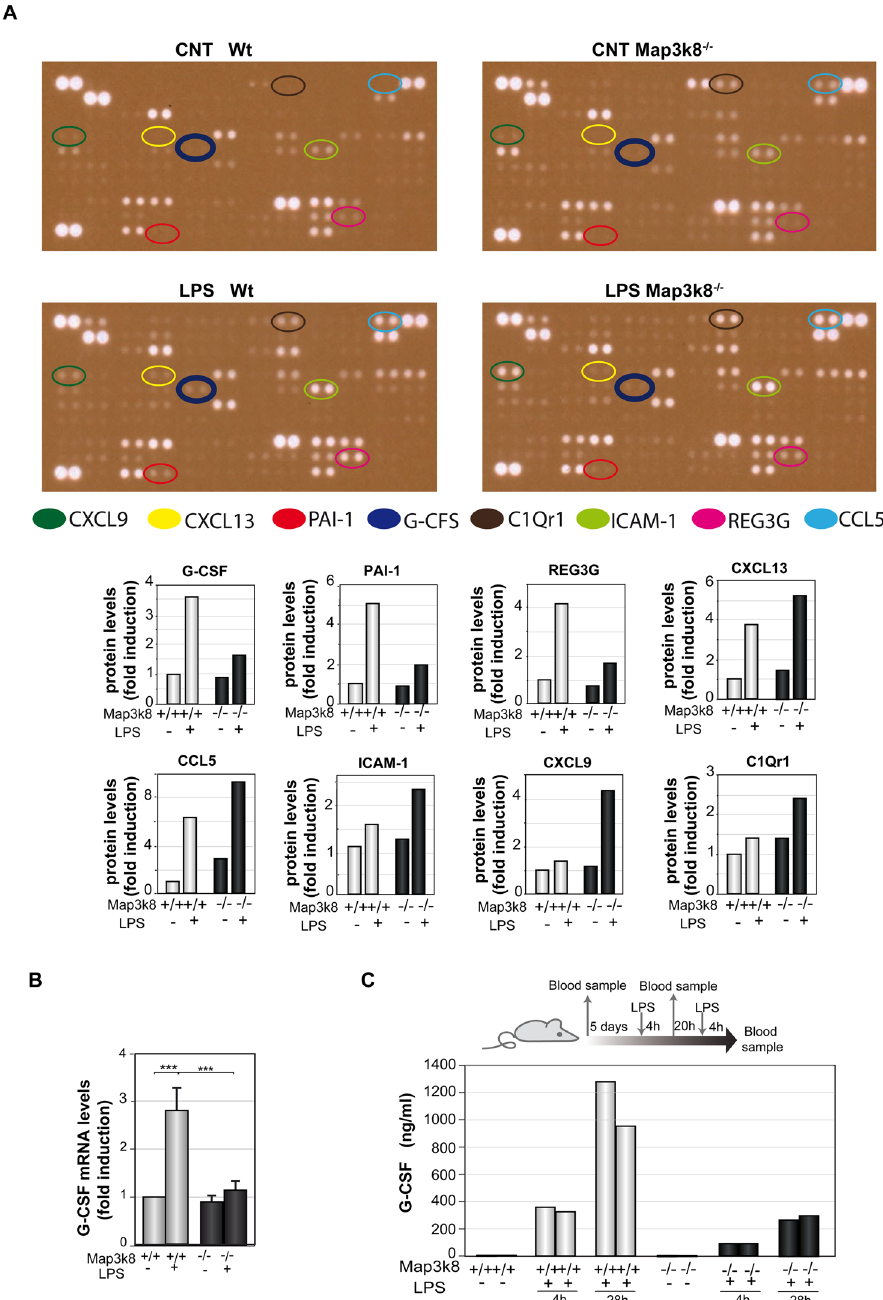
Figure 7. Map3k8 mediates G-CSF production in LPS-induced myelopoiesis. ( A ) Wt and Map3k8 − / − mice received injections of LPS or PBS at 0 and 24 h, and BM extracts were obtained 24 h later. Extracts ( n = 9) from untreated and LPS-treated Wt and Map3k8 − / − mice were pooled for analysis of the levels of 111 inflammatory proteins using a mouse XL cytokine array. A 3-min exposure of the arrays is shown. The expression of 8 proteins was modulated by Map3k8 deficiency in LPS-treated mice: chemokine (C-X-C motif) ligand 9 (CXCL9), chemokine (C-X-C motif) ligand 13 (CXCL13), plasminogen activator inhibitor-1 (PAI-1), receptor for complement component C1q (CIQr1), intercellular adhesion molecule 1 (ICAM-1), chemokine (C-C motif) ligand 5 (CCL5), and regenerating islet-derived protein 3 gamma (REG3G). Relative levels of the proteins modulated by Map3k8 are shown. ( B ) RNA was isolated from the BM of mice indicated in ( A ), and G-CSF mRNA levels were assessed by quantitative reverse-transcriptase polymerase chain reaction. The graph shows the mean ± SEM of 4 different experiments, each performed on a pool of cells from 2 animals. One-way ANOVA with Newman-Keuls correction was performed to compare groups. * p < 0.05, ** p < 0.01, *** p < 0.001. ( C ) Diagram of LPS treatment of and blood sample collection from Wt and Map3k8 − / − mice. The graph shows the circulating G-CSF levels, measured in duplicate from a pool of 3 mice each, at the indicated times after LPS